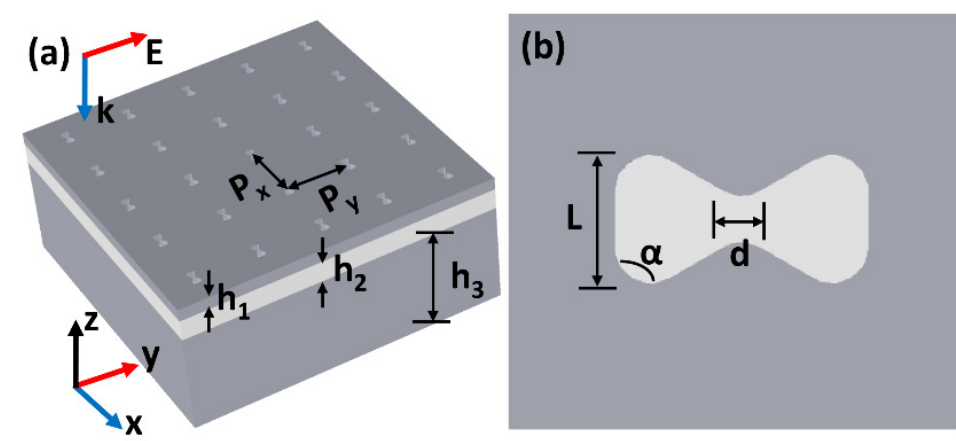
Figure 1. ( a ) Schematic of silver bowtie nanoholes structure. ( b ) Top view of the bowtie.